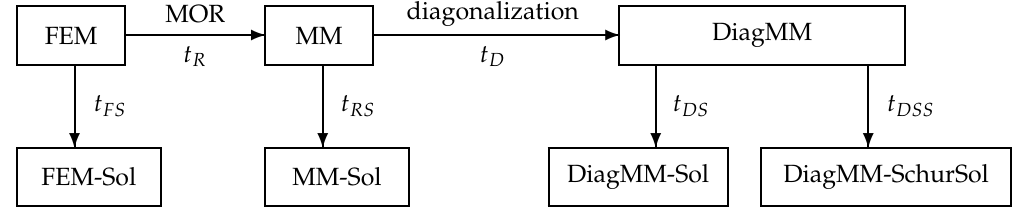
Figure 4. Diagram defining the time cost of MOR, diagonalization and solution of the systems of equations. Abbreviations: FEM , initial FEM system; MM , system with macromodels; DiagMM , system with diagonalized macromodels; -Sol , solution by means of the MATLAB solver mldivide ; -SchurSol , solution by means of the Schur solver.